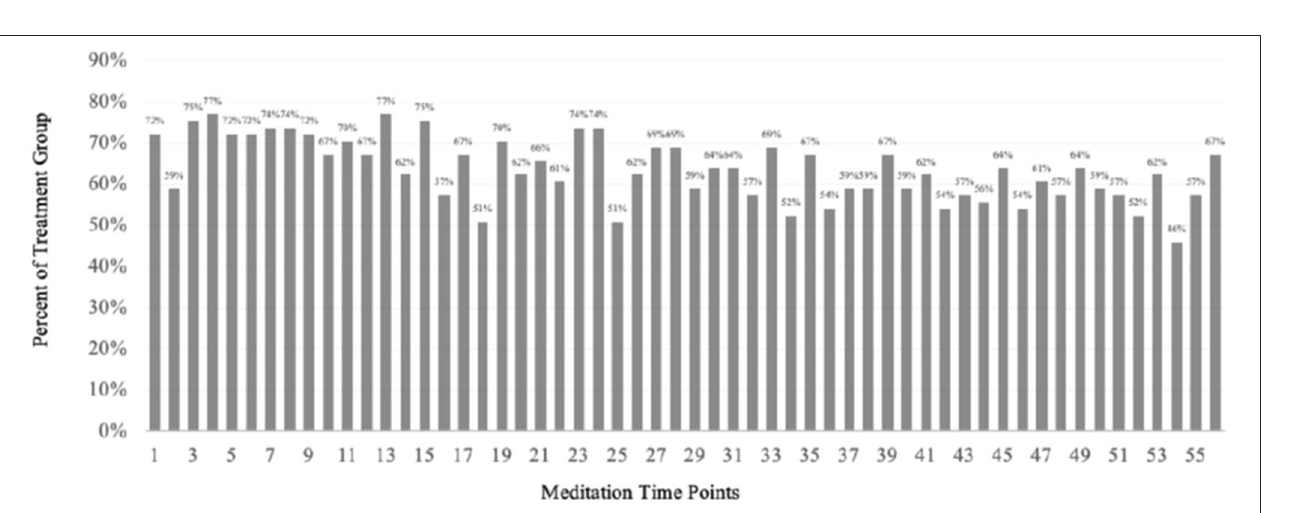
FIGURE 3 | Percentage of adherence in treatment group at each of the 56 meditation sessions in the 4-week